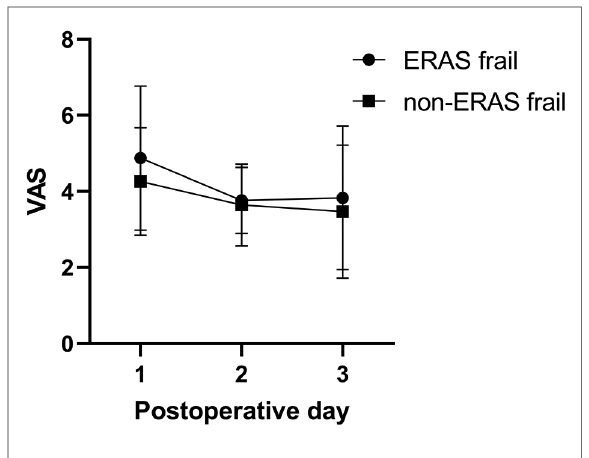
FIGURE 2 Pain scores on POD 1 – 3 between the ERAS frail group and the non- ERAS group. POD, postoperative day; ERAS, enhanced recovery after surgery.